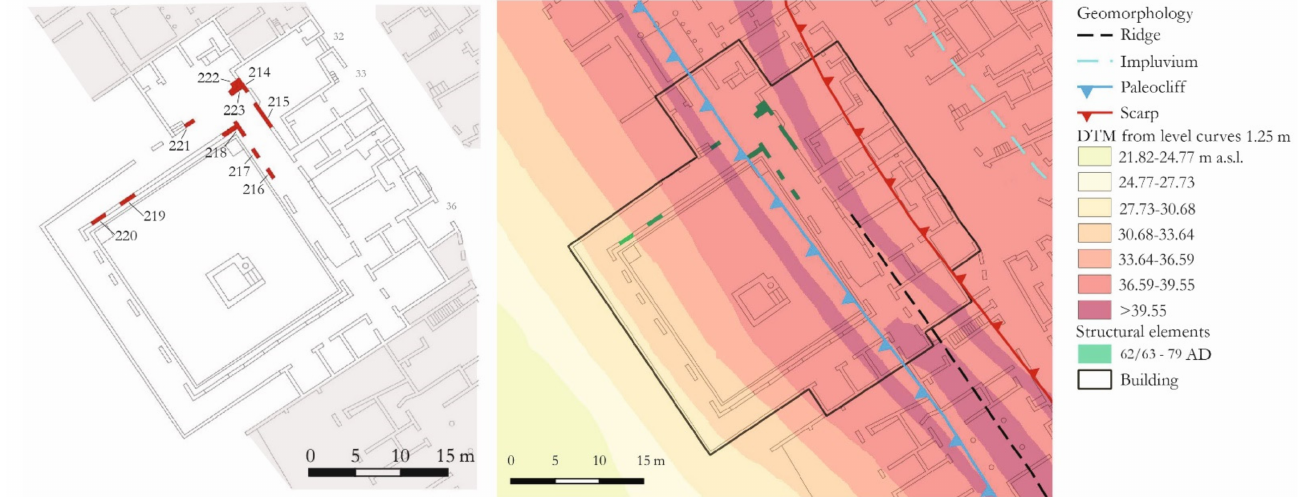
Figure 15. On the left is the plan of House of Diana II (VI 17, 32–36), with in red the structures built up with NYT elements. On the right, the plan of the geomorphological evidences in the same area (elab. M.